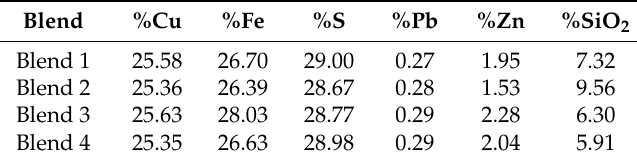
Table 8. Chemical composition of the blends studied.